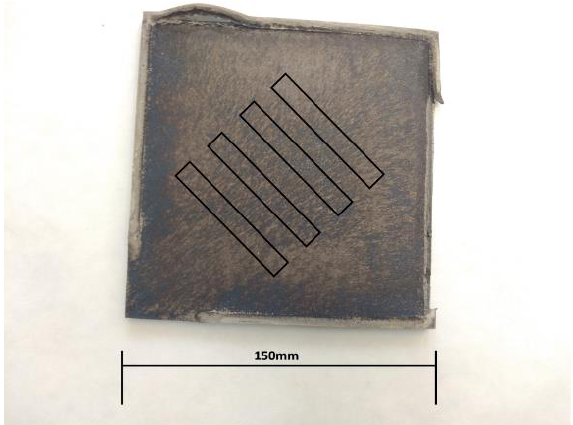
Figure 3. Diagram of the method of taking samples from sheet metal after deformation using the explosive method. Samples marked with a black outline are included at an angle of 45° to the edge of the bottom sheet.